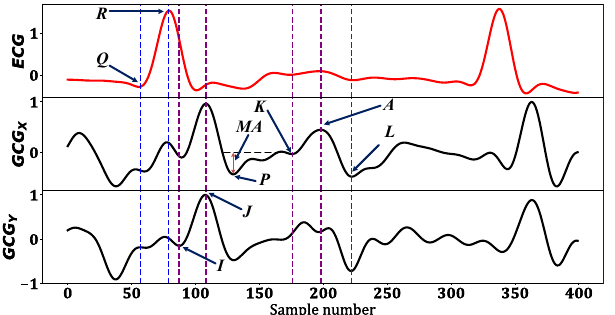
Figure 1. GCG X and GCG Y fiducial points and timing intervals annotated in this